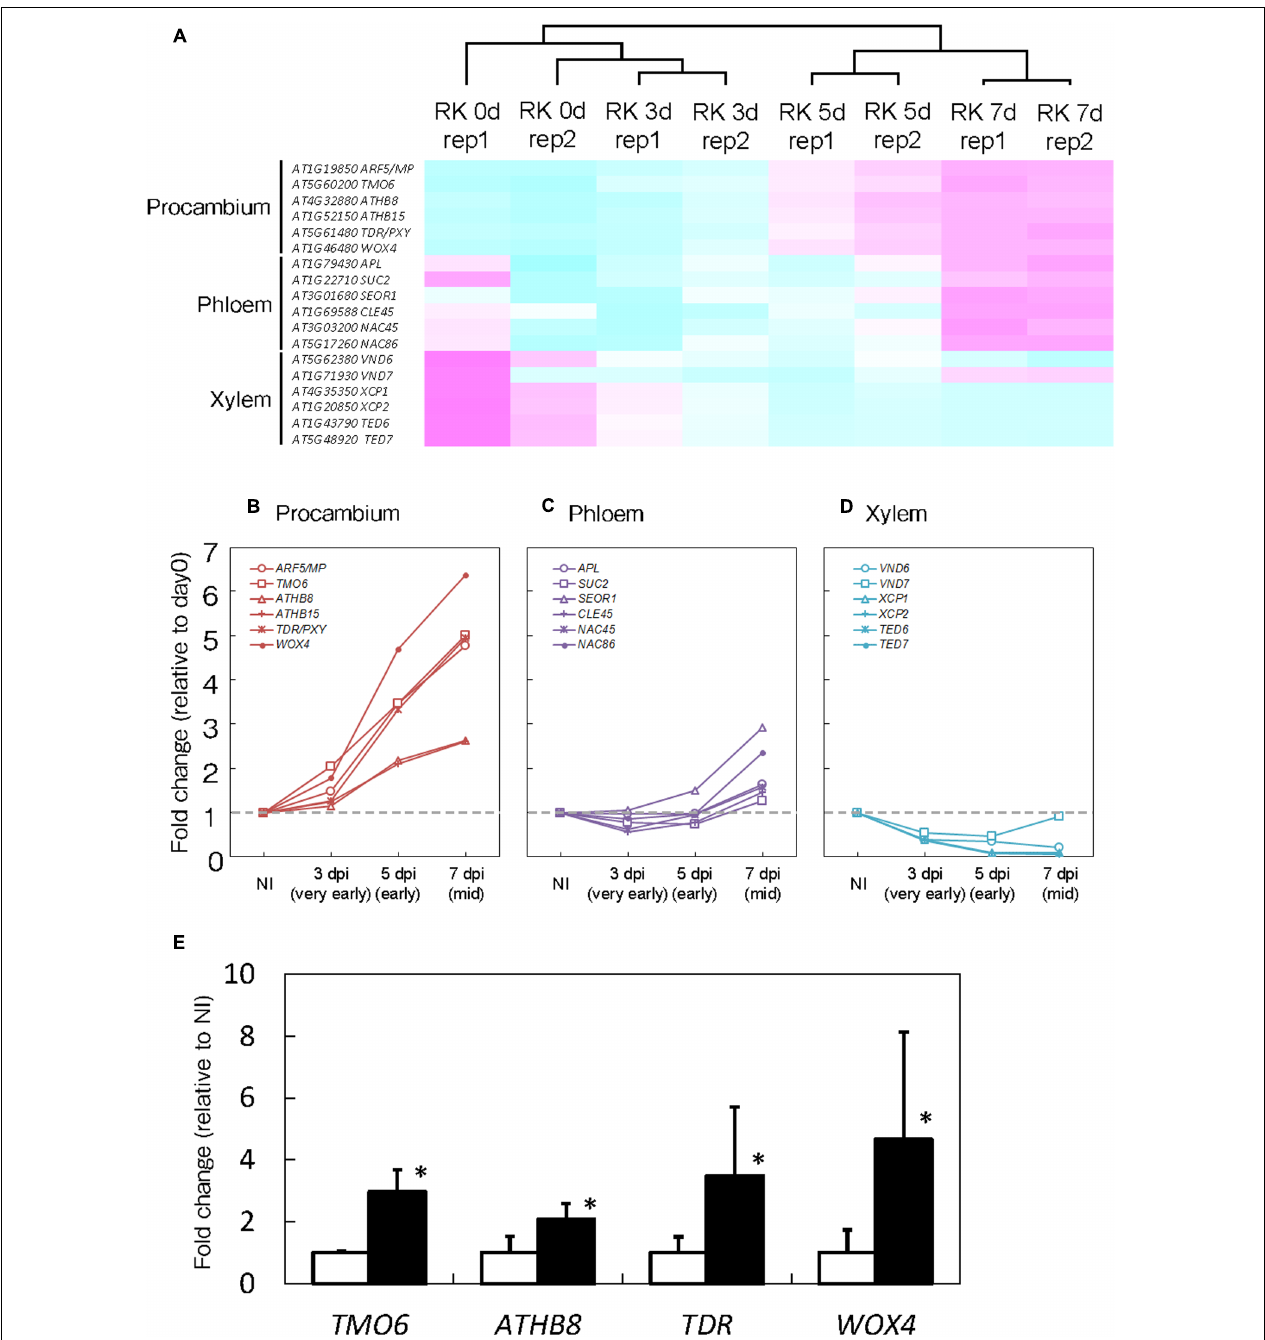
FIGURE 3 | Procambium-associated genes are highly expressed in galls. (A) Comparison of genes that are associated with vascular cell identities. Magenta indicates genes increased compared to median levels of the four samples, and cyan means decreased amount of mRNA in the heat map. Time-course expression profiles of the procambium-associated (B) , Ph-associated (C) and xylem-associated (D) genes in the mRNA sequence analyses. The mRNA levels were calculated at each time point by normalizing to the mRNA level before infection. Values are the average of two experiments. (E) Quantitative RT-PCR results that denote the expression of TMO6 , ATHB8 , TDR and WOX4 in 7 dpi galls and non-infected roots. Significant differences: ∗ P < 0.05: values are means of three replicates ± SDs.